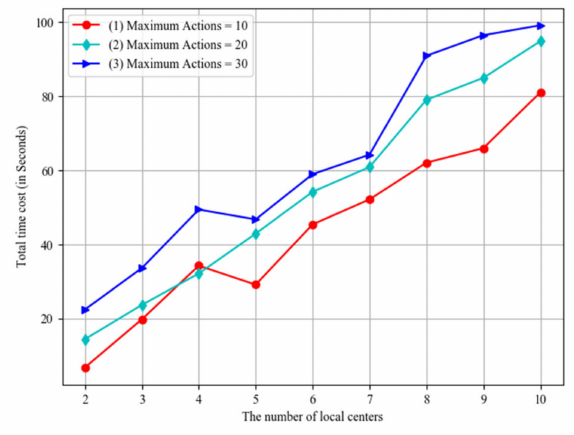
Figure 14. The impact of player